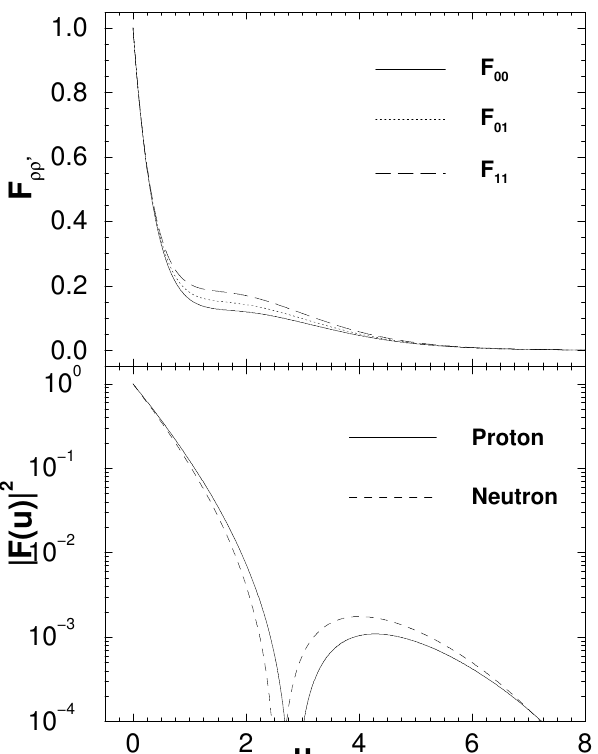
Figure 5. Spin structure functions and squared proton and neutron form factors for 23 Na for the ground state.